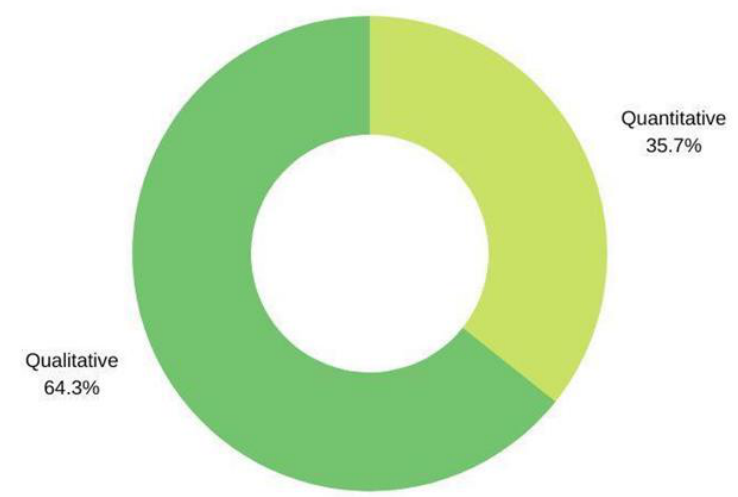
Figure 3. Distribution of studies by methodology used.